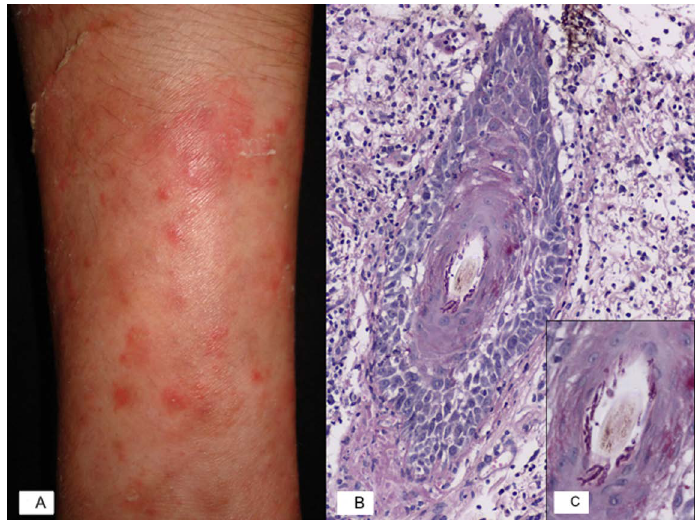
Figure 1. Inflammatory tinea: Majocchi’s granuloma. ( A ) Majocchi granuloma characterized by erythematous nodules on the forearm. ( B ) Microphotography of a PAS-stained slide shows a vellus hair with adjacent mixed inflammatory infiltrate, epithelium spongiosis, exocytosis of neutrophils, and hyphae surrounding the hair shaft. ( C ) Closer view of the vellus hair showing septate hyphae within the follicular